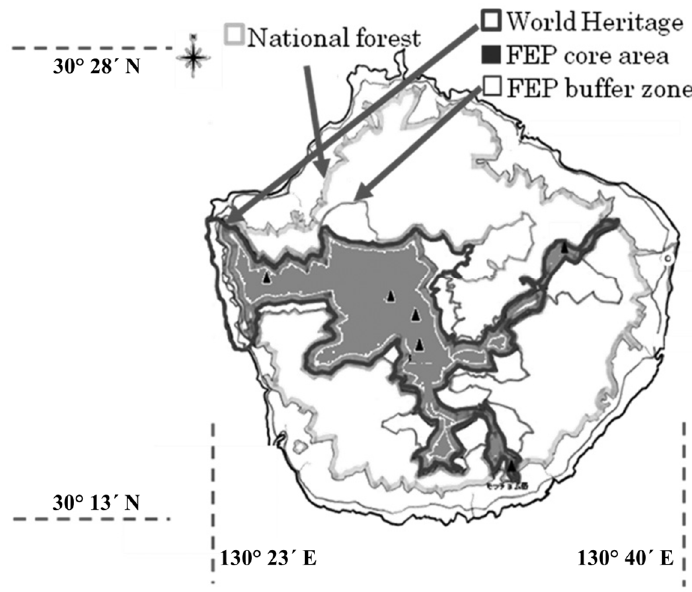
Figure 1. Yakushima Island showing the WHS and Forest Ecosystem Protected (FEP) area [38].